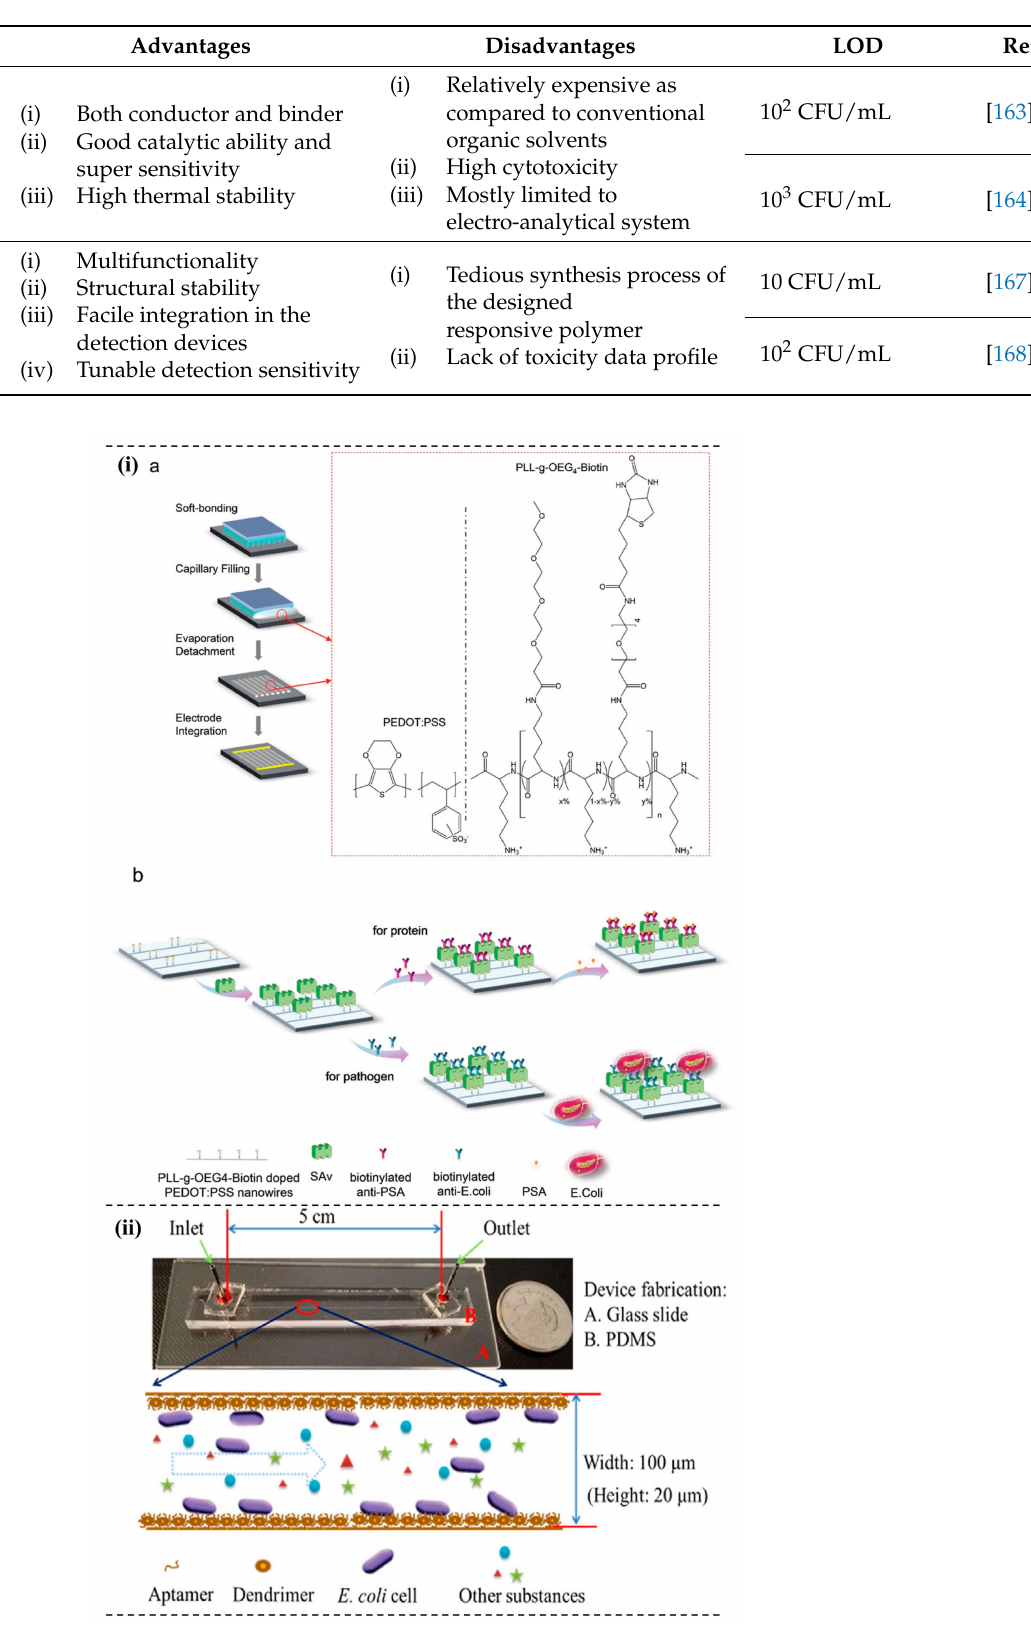
Figure 5. Responsive polymer-based pathogen detection system. ( i ) ( a ) Fabrication steps of